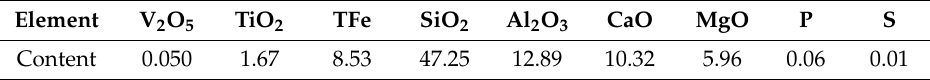
Table 1. Main chemical composition of raw sample (wt